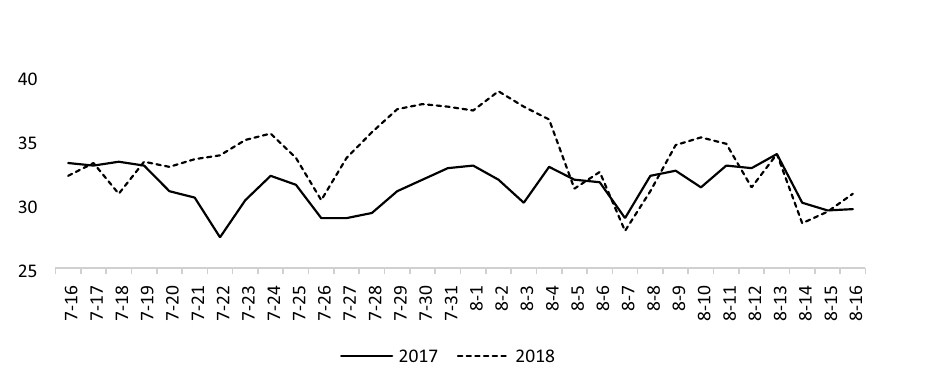
Table 1. Effects of bast fiber film and nano-silicon fertilizer on rice yield and yield components. Different letters indicate significant difference at 5% level. Summary of ANOVA results: not significant (ns), significant at p < 0.05 (*), very significant at p < 0.01 (**). Y Year, T Treatment.